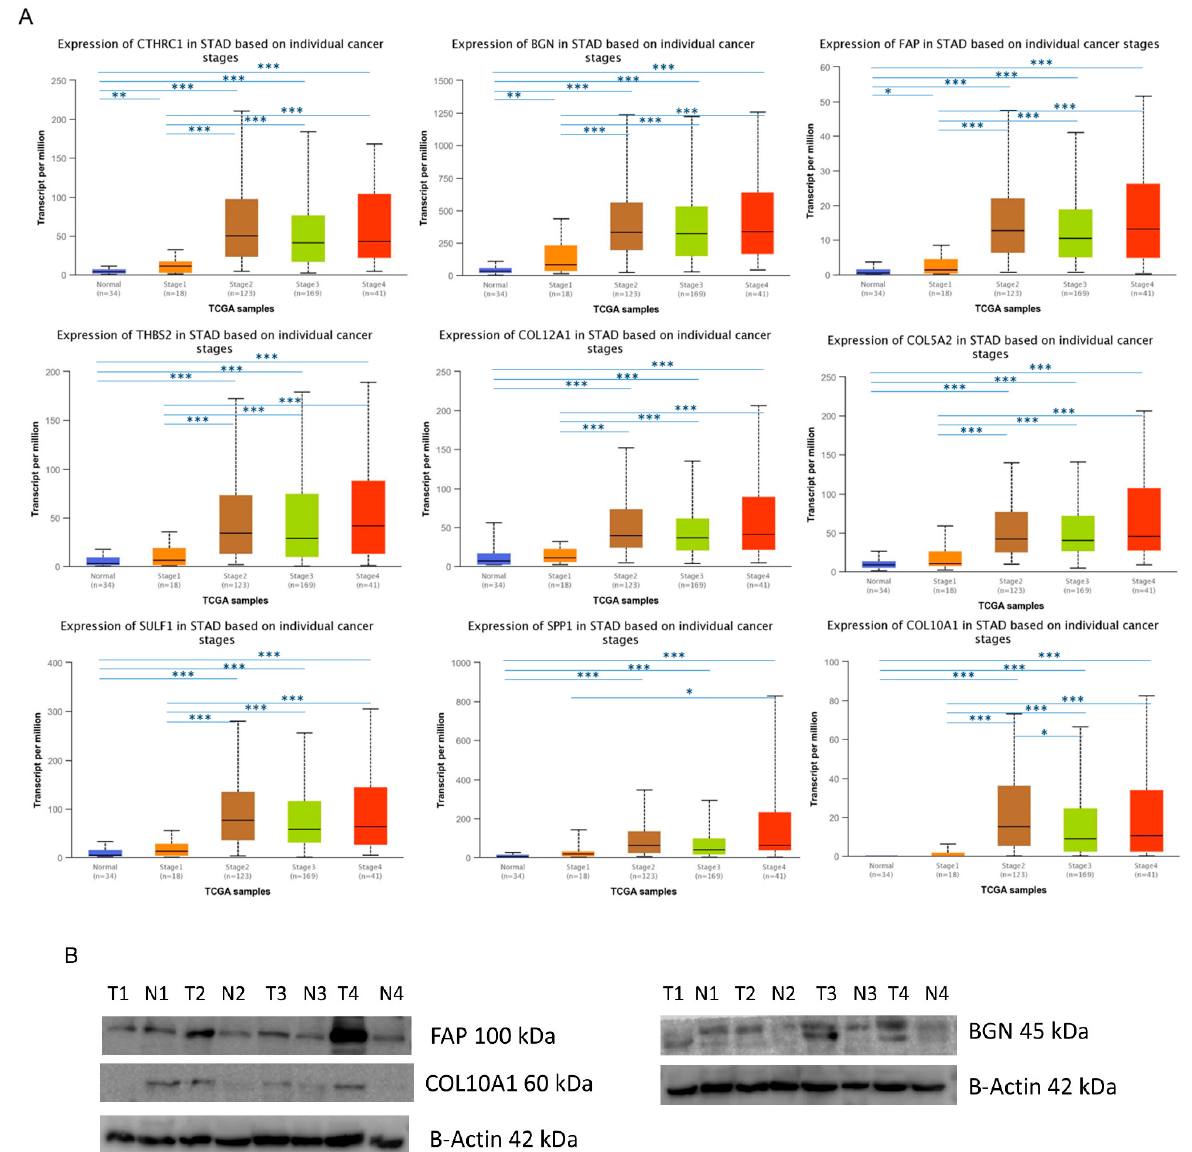
Figure 4. The expression levels of hub genes in GC. ( A ) The mRNA expression was correlated with pathological T stages. The asterisk represents the comparison between a specific stage and the normal group, or between different stages. * p < 0.05, ** p < 0.01, *** p < 0.001. ( B ) Representative western blotting for COL10A1, BGN, and FAP proteins in 4 paired gastric tumor (T) and adjacent non-tumor tissues (N) with progressive stages from T1 to T4.